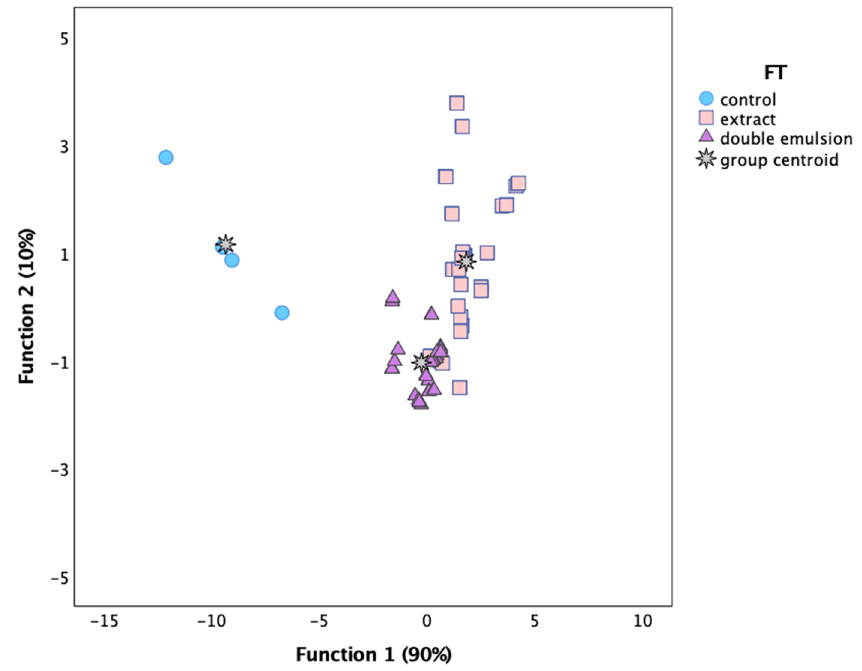
Figure 3. Three-dimensional distribution of FT markers according to the discriminant functions coefficients defined from the colorimetric parameters. Table 4. Proximal composition of the base drinks (Yogurt, Rice, Milk, and Soy) and corresponding colored counterparts added with extract (Extract) and double emulsion (Double Emulsion). The values are expressed in g/100